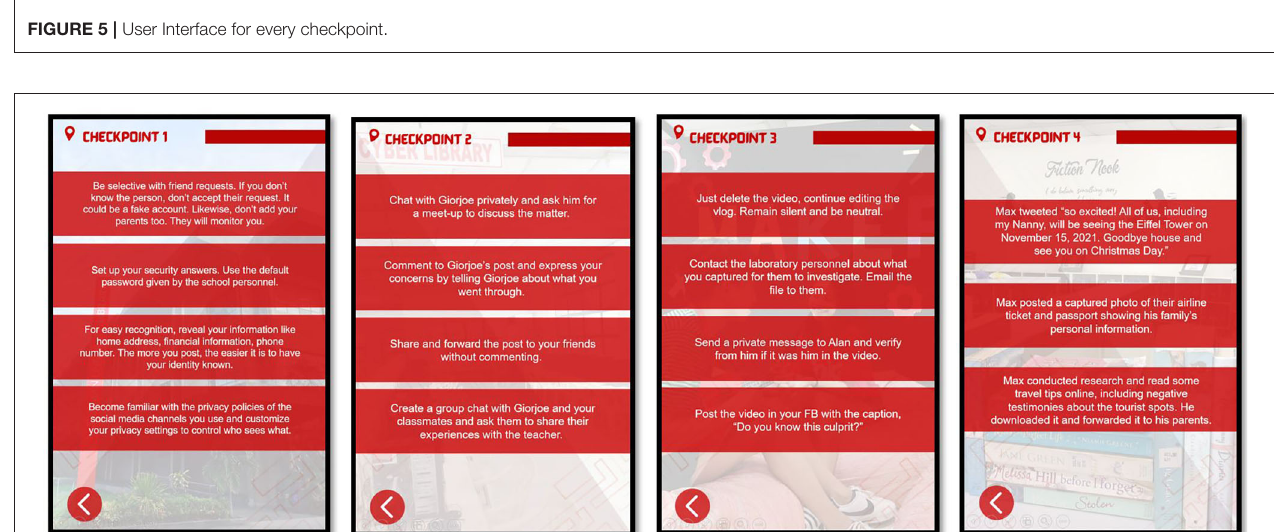
FIGURE 5 | User Interface for every checkpoint.